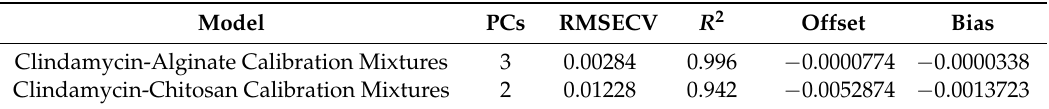
Table 1. Statistical parameters from leave-one out cross validation (CV) of chemometric models for drug–polymer calibration mixtures in the range of 190–250 nm.